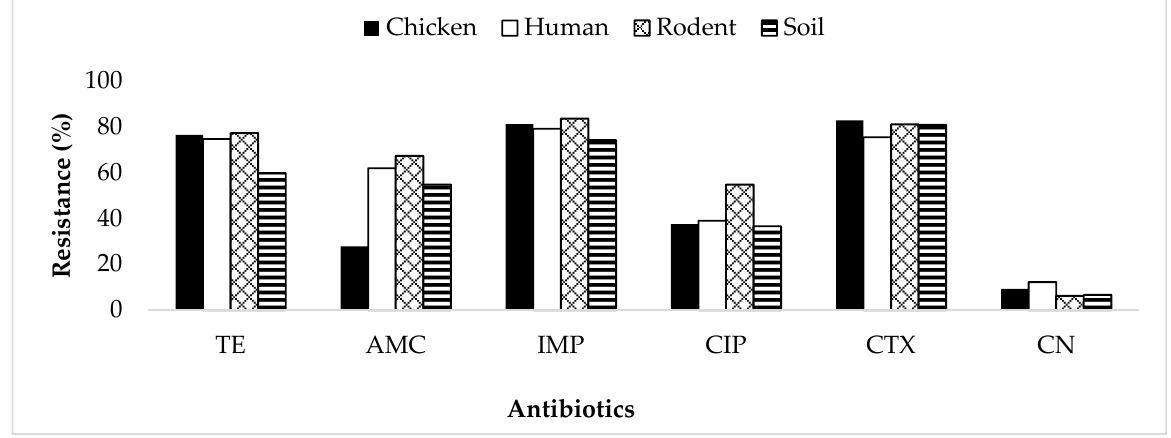
Figure 1. Resistance rates of E. coli isolates to different classes of antibiotics. TE = tetracycline; AMC = amoxicillin-clavulanate; IMP = imipenem; CIP = ciprofloxacin; CTX = cefotaxime; CN = gentamycin. Table 2. Antibiotic resistance and MDR rates of Escherichia coli isolates from chickens, humans, rodents and soil samples. Number of Antibiotic Classes to Which the Isolates Were Resistant, Types of n (%) Sample